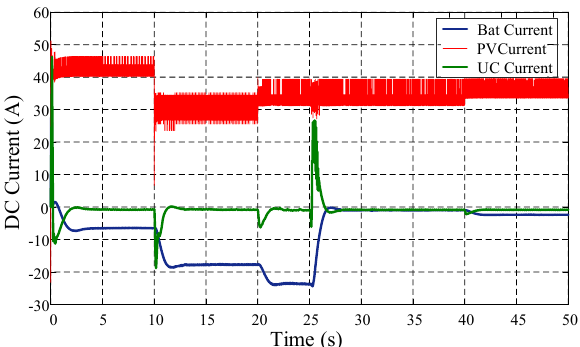
Figure 19. Current profiles: PV (red), battery (blue), and ultracapacitor